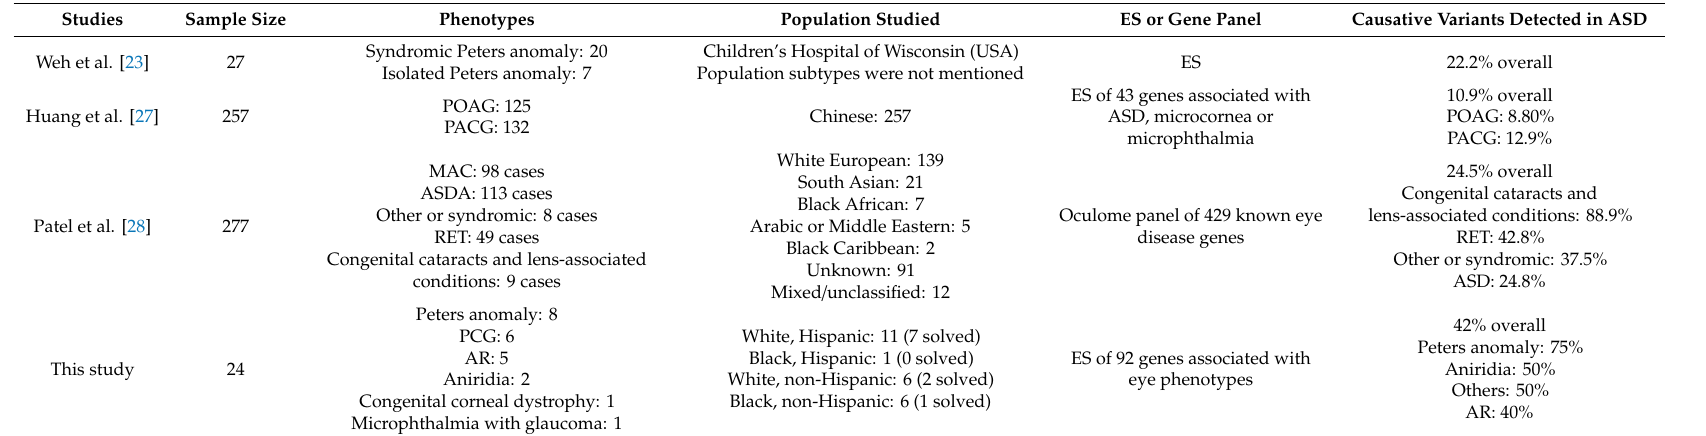
Table 3. Causative variant detection in published